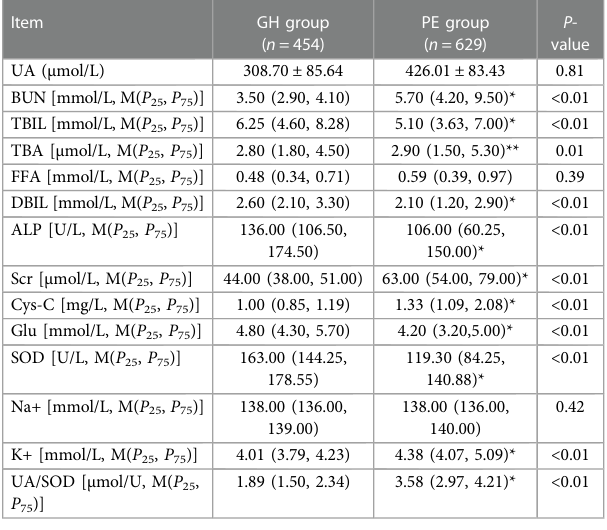
this study, nomogram was constructed and 3 independent risk factors included for visualization of the logistic model. In the nomogram, UA/SOD was the greatest predictor of PE (100 points), followed by SBP (29 points), and serum potassium (19 points) ( Figure 4 ). The scoring system was used to plot the ROC curve for the validation set. The area under the curve was 0.92 (95% CI: 0.90 – 0.95). The maximum Youden index was 0.73, Table 4 ). The calibration analysis curve found that the